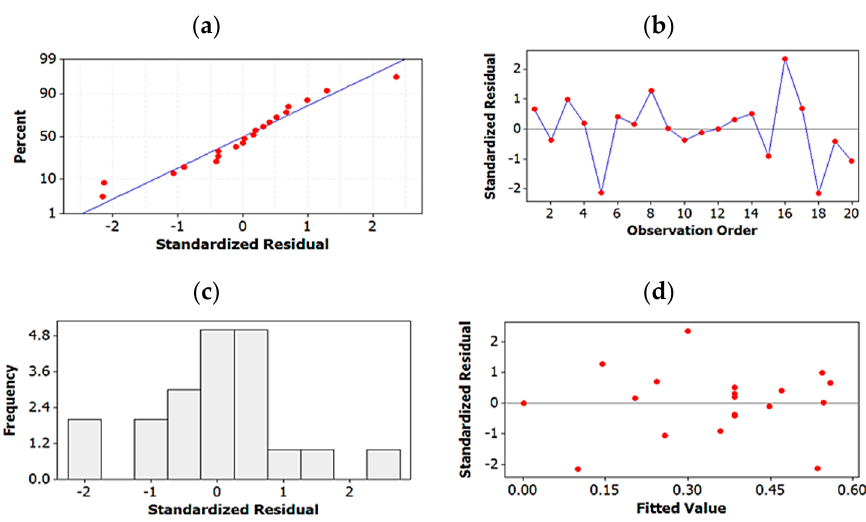
Figure 5. Residual plots for R s2 : ( a ) normal probability plot of residuals, ( b ) residuals-vs.-fit plots, ( c ) histogram of residuals, ( d ) residuals-vs.-order of data.